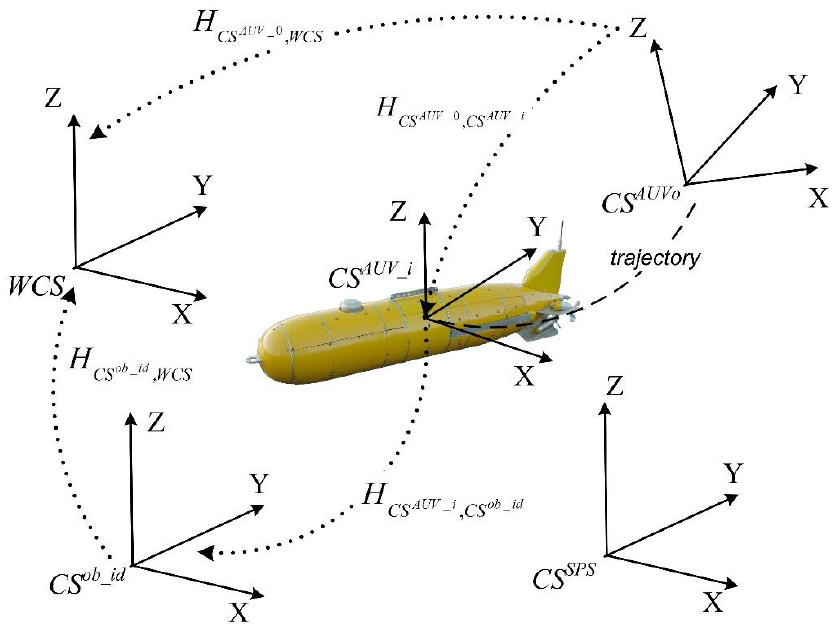
Figure 3. Coordinate systems (WCS, CS SPS, object CS, CS associated with an AUV in the initial and current positions) used and geometric transformations between them.